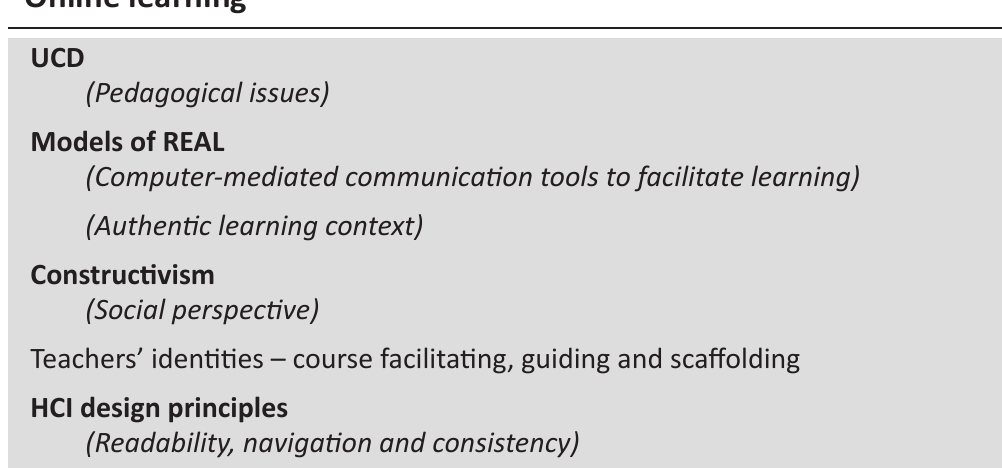
Figure 1. Designing by constructivism model created by the author intended for this